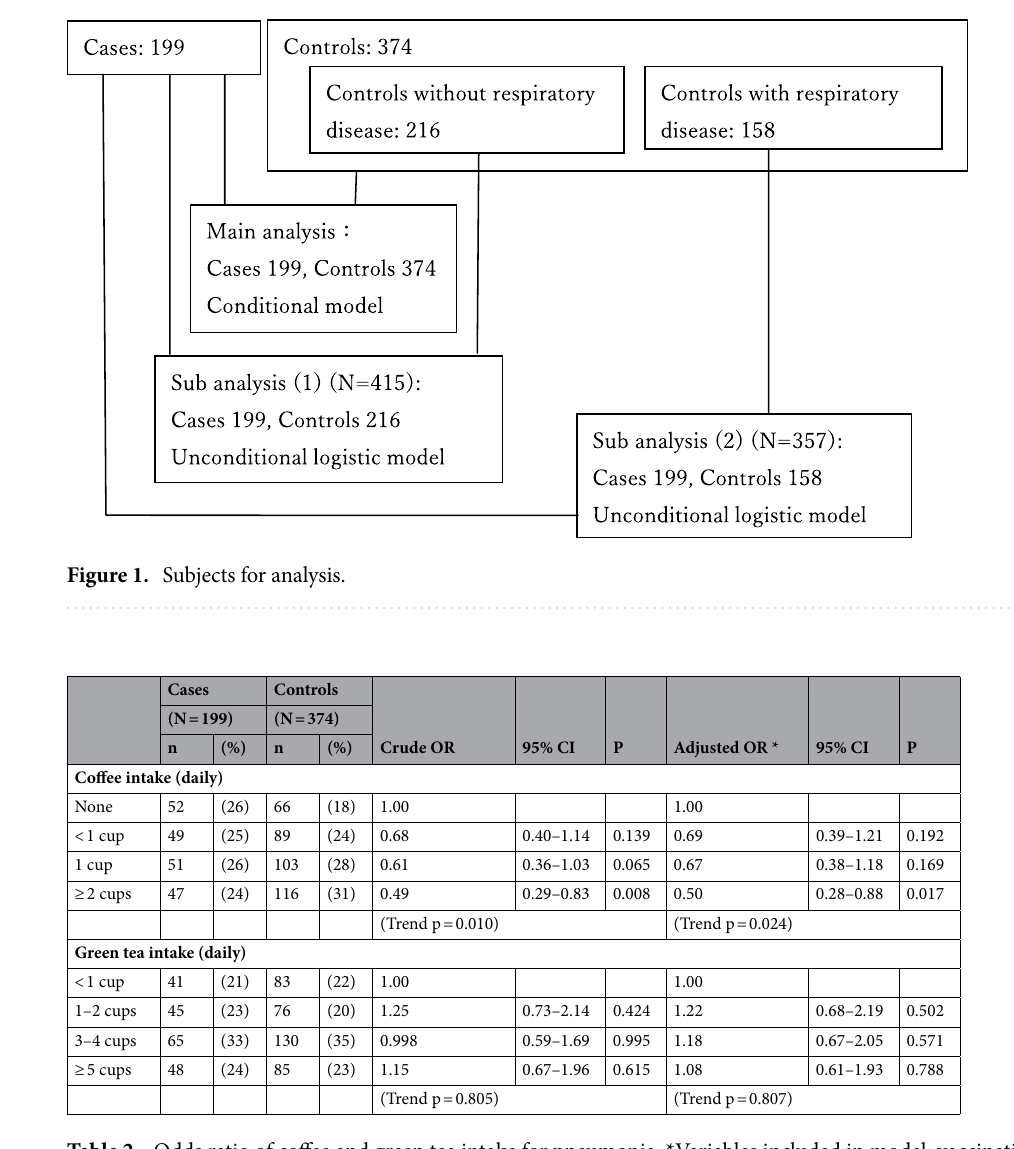
Table 2. Odds ratio of coffee and green tea intake for pneumonia. *Variables included in model: vaccination status (pneumococcal, influenza), BMI, underlying disease (respiratory disease, hypertension, diabetes mellitus, heart disease), ADL, children ≤ 6 years old living in same household, current smoking habit, current alcohol drinking habit, coffee intake, and green tea